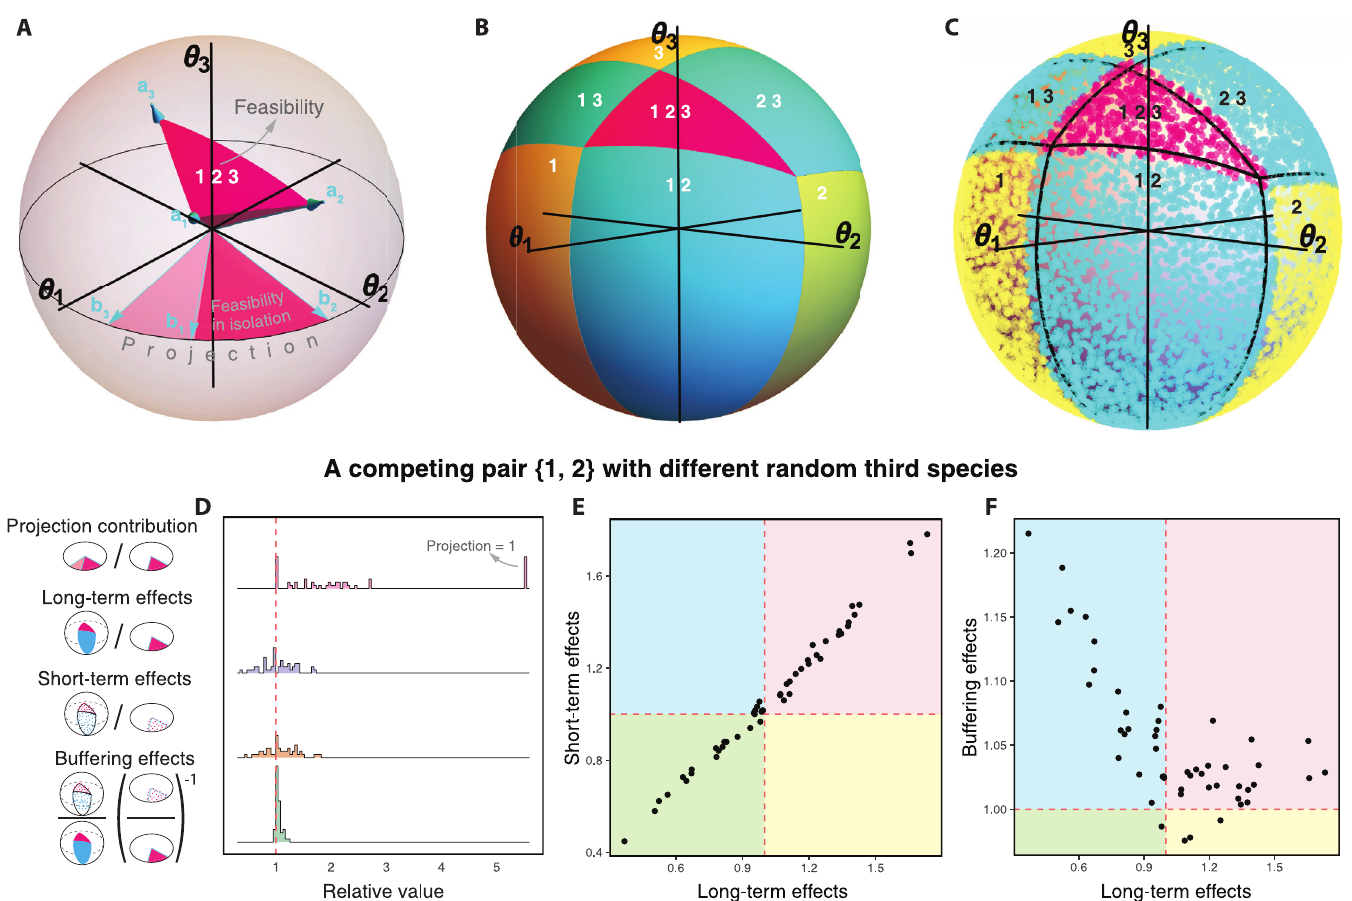
Fig 1. Geometric perspective of the effect of third-party species on pairwise coexistence. For a fictitious system of three species, Panel A shows the geometrical representation of the feasibility region D ð S ) (i.e., pink cone spanned by a 1 , a 2 , a 3 ) of an illustrative three-species system S characterized by the interaction matrix A 2 F ð Z ; S ) of the spanning rays onto the two-dimensional R 3 � 3 in the three-dimensional space of effective growth rates ( θ 1 , θ 2 , θ 3 ). The panel also shows the projection D Proj ð Z ) is given by plane ( θ 1 , θ 2 ) of the pair Z ¼ f 1 ; 2 g (i.e., light pink and dark pink disk spanned by b 2 , b 3 ). The feasibility of pair {1, 2} in isolation (i.e., a 2-species pool) D F b 1 , b 2 (i.e., dark pink disk), and becomes a fraction of the projection corresponding to the possible coexistence of species 1 and 2 only. Panel B illustrates the geometric partition of the analytical feasibility regions of all possible compositions in the previous three-species system. For the same system, the points in Panel C show the resulting species composition (species with final abundances N < 10 − 6 are considered statistically extinct) from 10,000 simulations over a short finite time interval (total time = 200, stepsize = 0.01) conducted by the Runge-Kutta method. Note that these results are a function of the time span of simulations (see S7 Fig), although the qualitative effects are similar for other choices of time span. The black lines correspond to the borders of the analytical feasibility regions in Panel B . Panel D shows the distribution of system-level effects calculated on a fixed hypothetical pair of symmetrically competing species Z ¼ f 1 ; 2 g when assembled with different random third species. The distributions are generated using 50 random third species (see text for details). Each point in the distributions corresponds to the same pair with a different set of third-party species. For reference, the dashed line shows the value of one: the relative feasibility in isolation. Panels E-F show the positive and negative association of the long-term effect with the short-term and buffering effects, respectively (Panel E : Pearson’s product-moment correlation = 0.995, p - value < 0.001; Panel F : Pearson’s product-moment correlation = − 0.707, p - value < 0.001). These results are complemented by a perturbative analysis for weakly interacting systems in S5 Appendix.